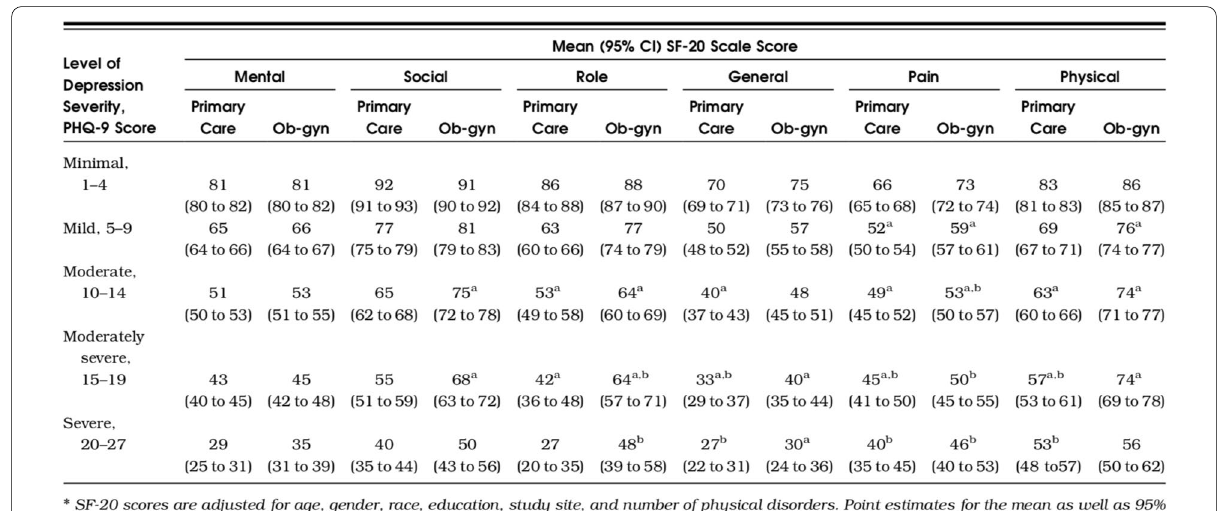
Fig. 2 The relationship between depression severity and personal health-related functionalities